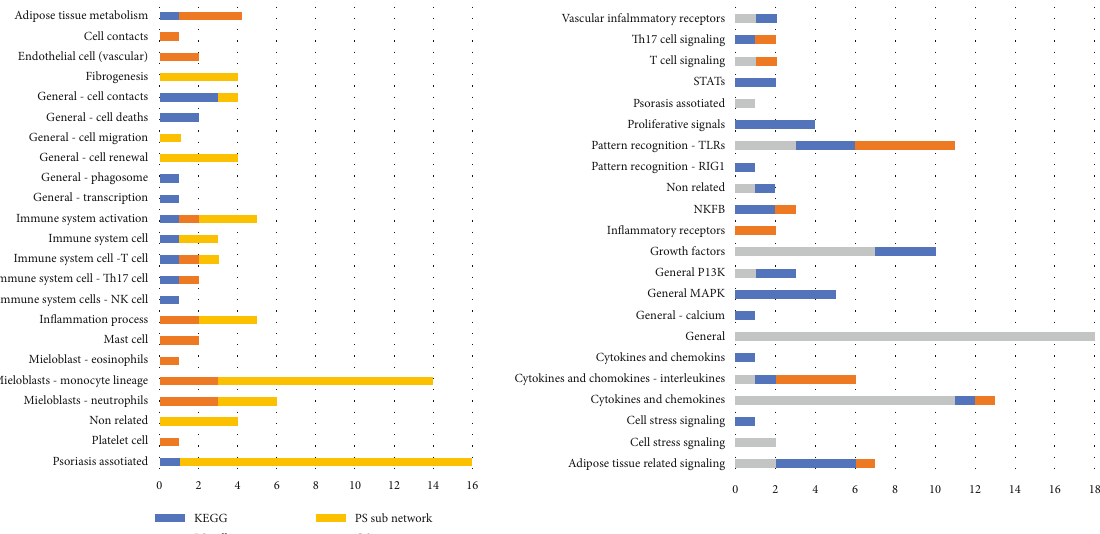
Figure 2: Cellular processes associated with members of PPAR γ -downregulated signaling associated with psoriasis. Numbers are for the sum of pathways, subnetworks, or GO groups in each category. Di ff erent sources are highlighted with blue (KEGG database), orange (Pathway Studio Pathway Collection), light orange (Resnet-2020 database), and grey (GO). For the complete list of results, see supplemental materials ( “ PPARG network analysis ” fi